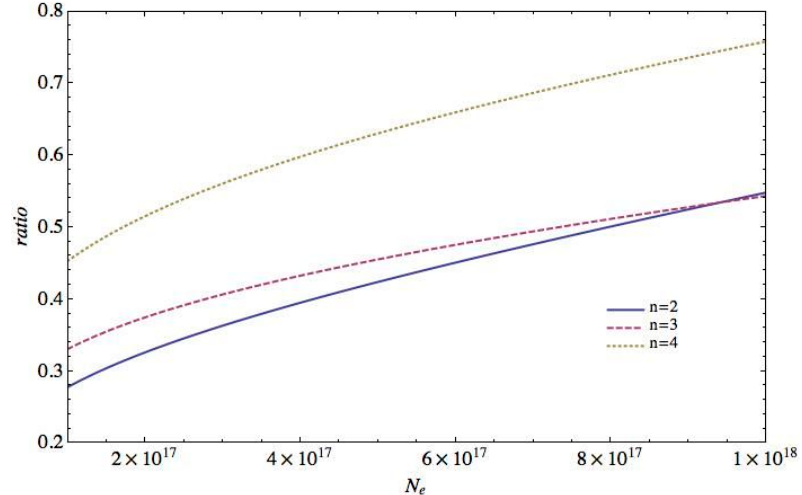
Figure 1. Ratio from Equation (2.13) versus the electron density N e for the Stark components of the electric quantum number |q| = 1 of Lyman-alpha ( n = 2), Lyman-beta ( n = 3), and Lyman-gamma ( n = 4) lines of He II at the temperature T = 8 eV [14].